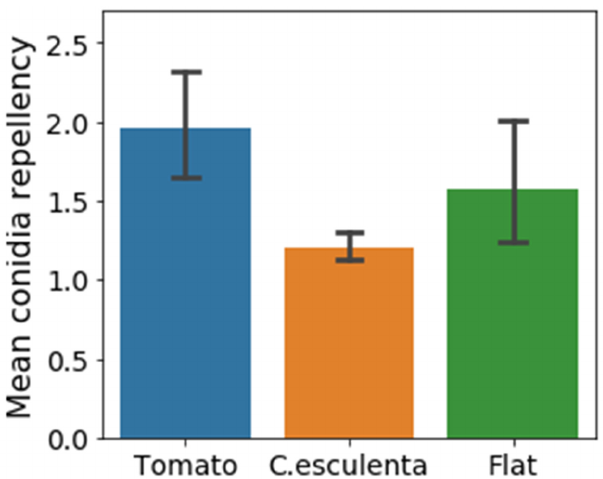
Figure 3. Conidia repellency ability of synthetic surfaces. Conidia repellency values of three PDMS surfaces: C. esculenta and tomato leaf replicas (orange and blue respectively) and flat surface (green) as a control for a structure less surface with the same chemical properties. Pairs comparison was conducted using Student’s t -test, 𝛼 was adjusted using Bonferroni correction. The microstructure of tomato leaves seemed to induce significantly higher conidia repellency values (1.9 ± 0.18) than the texture of C. esculenta leaves (1.2 ± 0.05) ( p < 0.01).